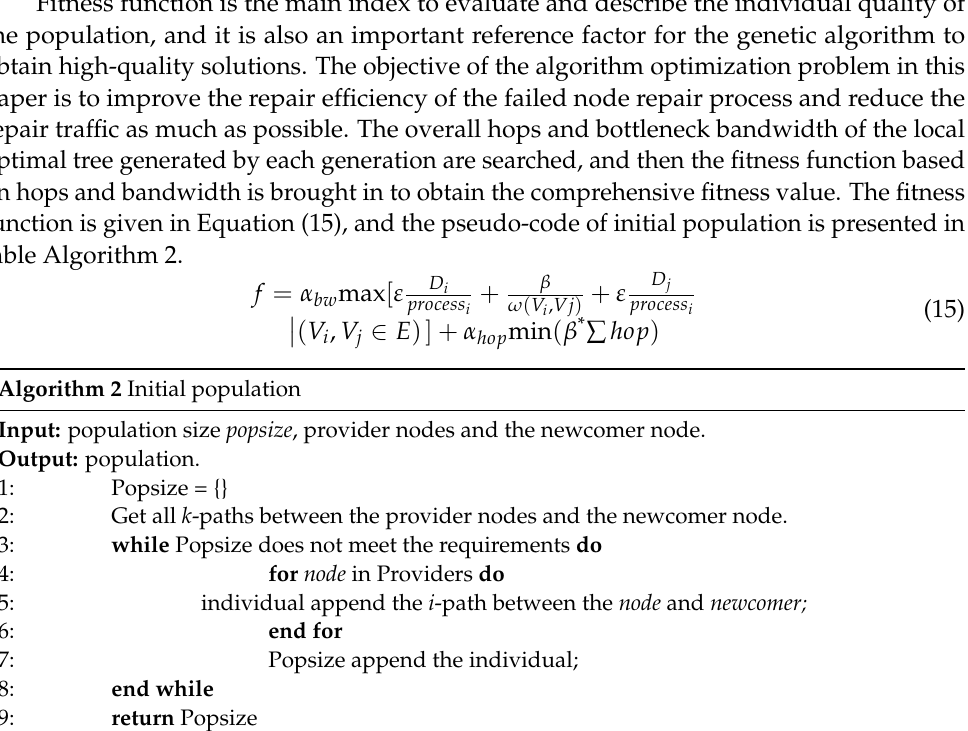
Figure 5. k -path coding and population initialization.